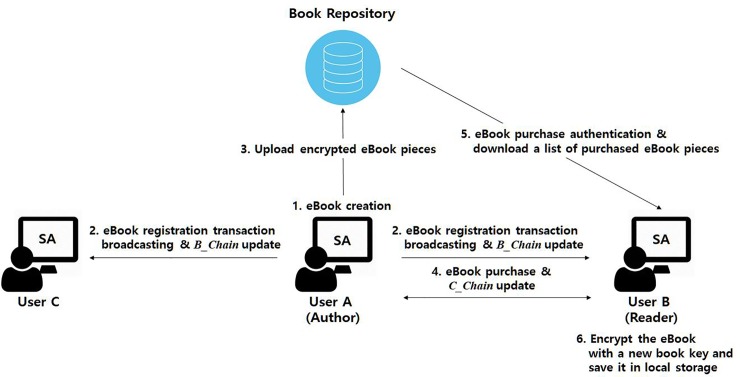
eBook transaction system configuration and the operation of eBook publishing and purchasing.